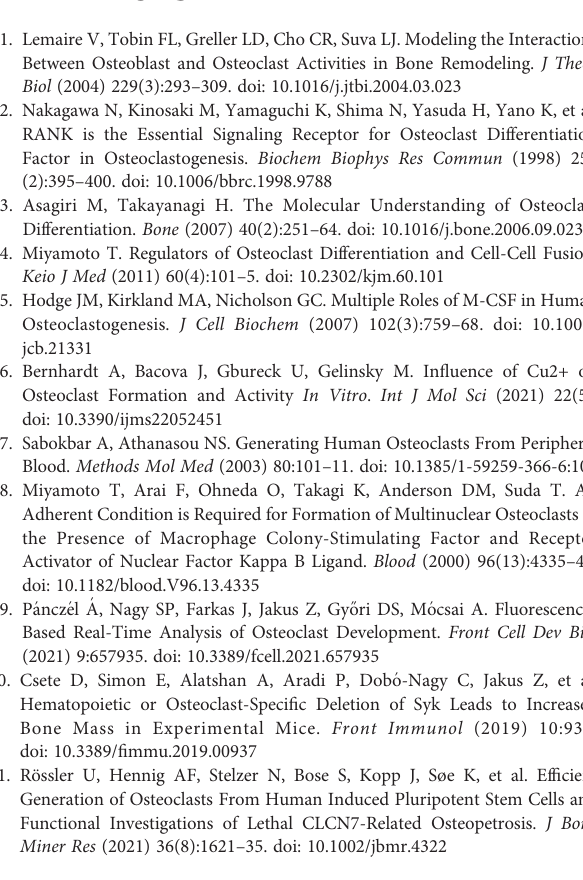
Supplementary Figure 1 | Several parameters had no signi fi cant effect on the clusteringofthesamples.PCAanalysisrepresenttheclusteringofsamplesbasedon (A) : rheumatoid factor (RF), (B) : cyclic citrullinated peptide (anti-CCP), (C) : C-reactive protein (CRP), and (D) : erythrocyte sedimentation rate (ESR) laboratory parameters, and (E) : DAS-28 score and (F) : duration of disease. Supplementary Figure 2 | In silico mixing of osteoclast proteins with monocyte or preosteoclast samples. PCA analysis of healthy and RA osteoclast proteins. Either healthy (middle row) or RA (bottom row) osteoclasts were mixed with monocyte or preosteoclast proteins with weights of 0.1 and 0.3 and compared to unmixed samples (upper left).